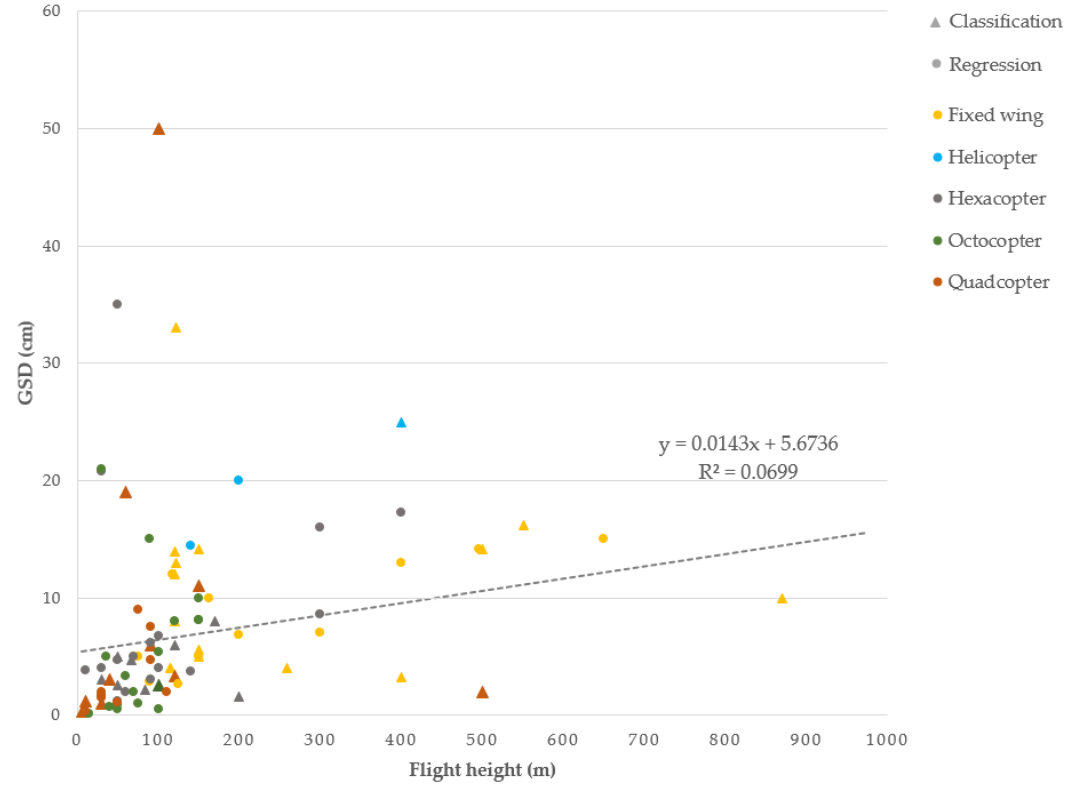
Figure 16. Ground sampling distance (GSD) vs. flight height for different platform types.